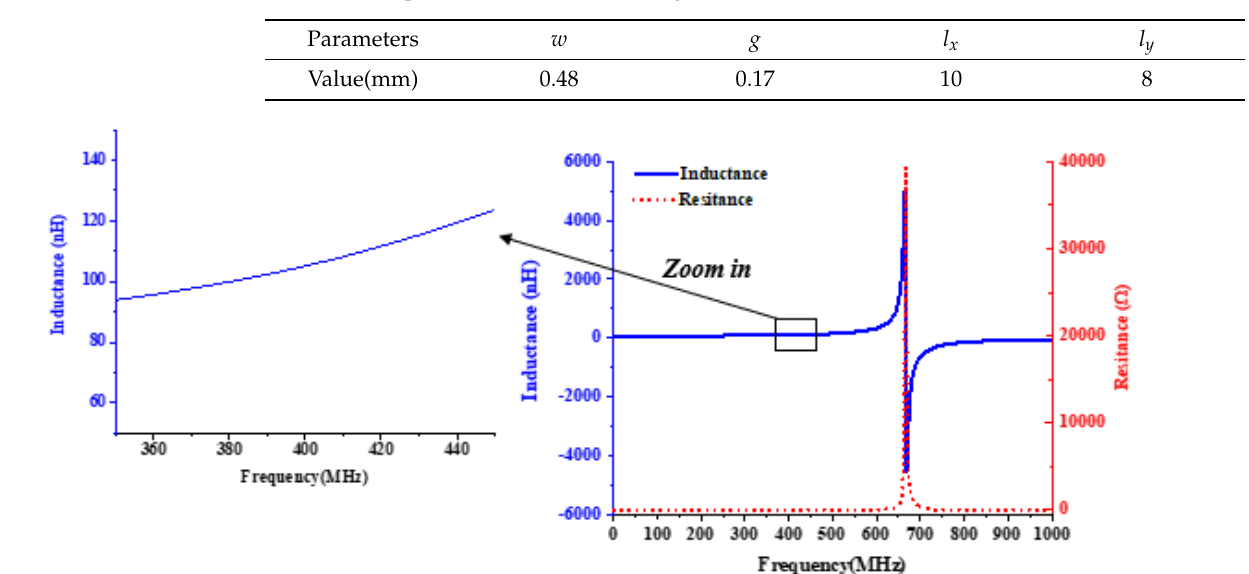
Figure 2. Simulated inductance and resistance of the conventional rectangular PSC.